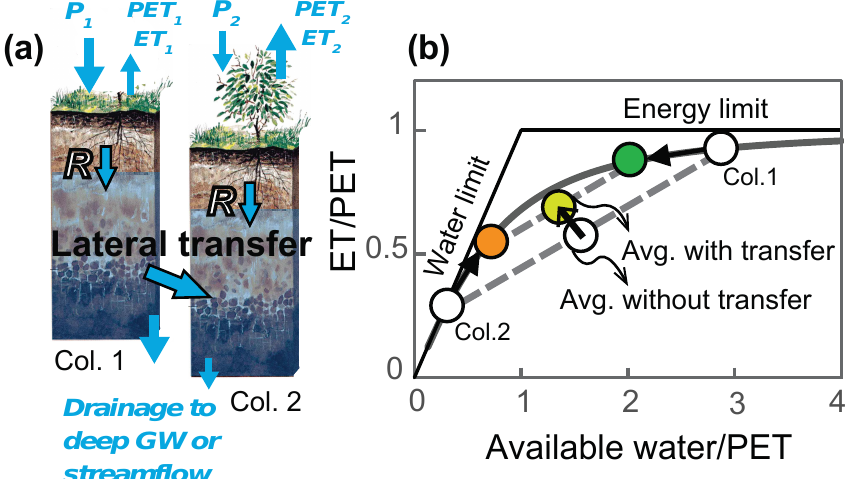
Figure 6. (a) A conceptual two-column model. (b) Illustration of how the two points representing the two columns shift towards each other in Budyko space if water is transferred from the upper, wetter column to the lower, drier column. Open circles represent columns without lateral transfer and solid circles represent columns with lateral